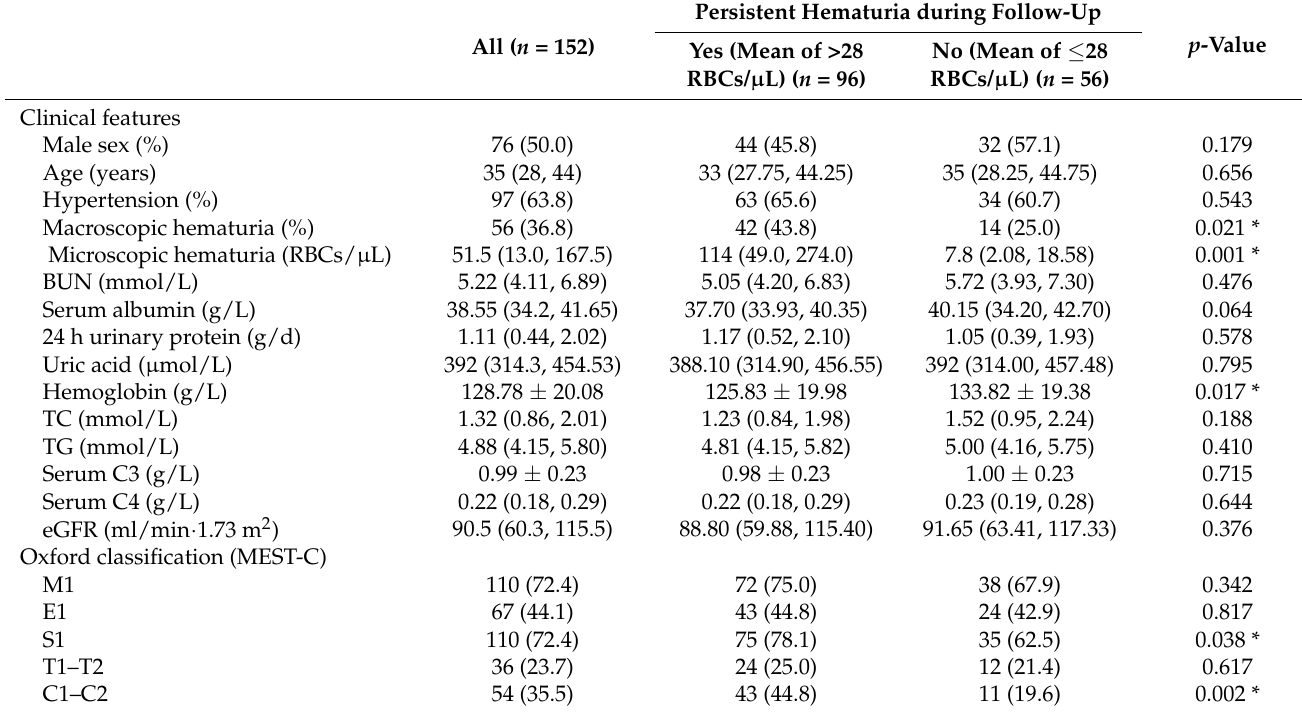
Table 1. Baseline characteristics of participants with IgAN according to TA-hematuria.